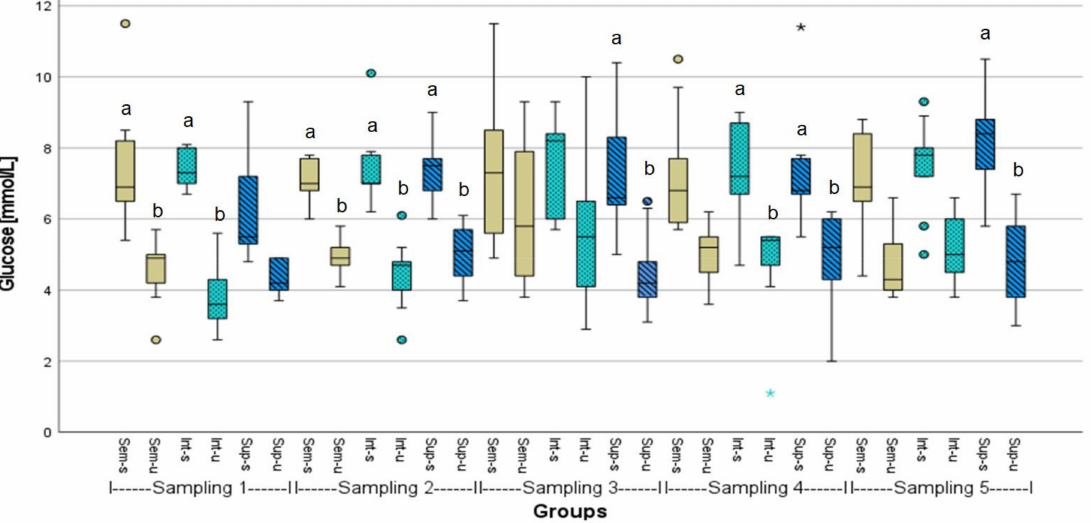
Figure A4. Glucose levels of stressed (s) or unstressed (u) African catfish (n = 9) under three different stocking densities (Sem = semi-intensive, Int = intensive, Sup = super-intensive). Kruskal-Wallis test with Tukey-HSD or Dunnett-T3 post hoc test, significances ( p < 0.05) are only given within the respective samplings, marked by letters. Circlets = outliers; asterisks = extreme values.